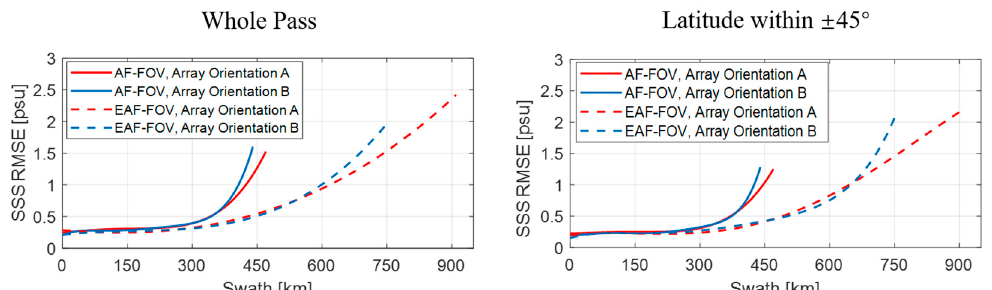
Figure 12. Illustration of the fitting results of the SSS root mean square errors (RMSE) variation versus the distance to the swath center, considering the ideal case 1, i.e., with no errors in SST and WS. The results of array orientations A and B are shown as red and blue lines, and the results for the AF-FOV and EAF-FOV are shown as solid and dashed lines, respectively. The subplots in the left and right panels present the results of the whole pass and of part of the pass with latitude within ±45°.